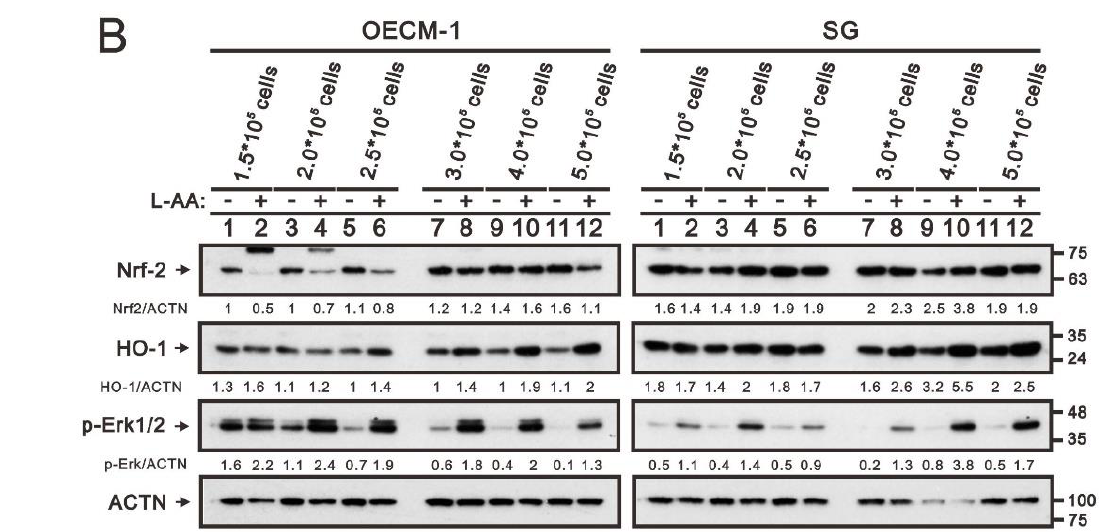
Figure 5. Effects of sodium ascorbate and L-ascorbic acid on Nrf2, HO-1, and p-Erk proteins in OECM-1 and SG cells. Indicated cell densities of OECM-1 and SG cells were cultured in 6-well plates and treated with 10 mM ( A ) sodium ascorbate for 3.5 h or ( B ) L-ascorbic acid for 5.5 h. The cell lysates (30 µg total proteins) were subjected to Western Blot analysis using antibodies against the indicated proteins. ACTN was a loading-protein control. The protein bands ( A ) and ( B ) were quantified through pixel density scanning and evaluated using Image J, version 1.44a (http://imagej.nih.gov/ij/) (accessed on 1 February 2023). The ratios of protein/ACTN were listed in the OECM-1 and SG cells.